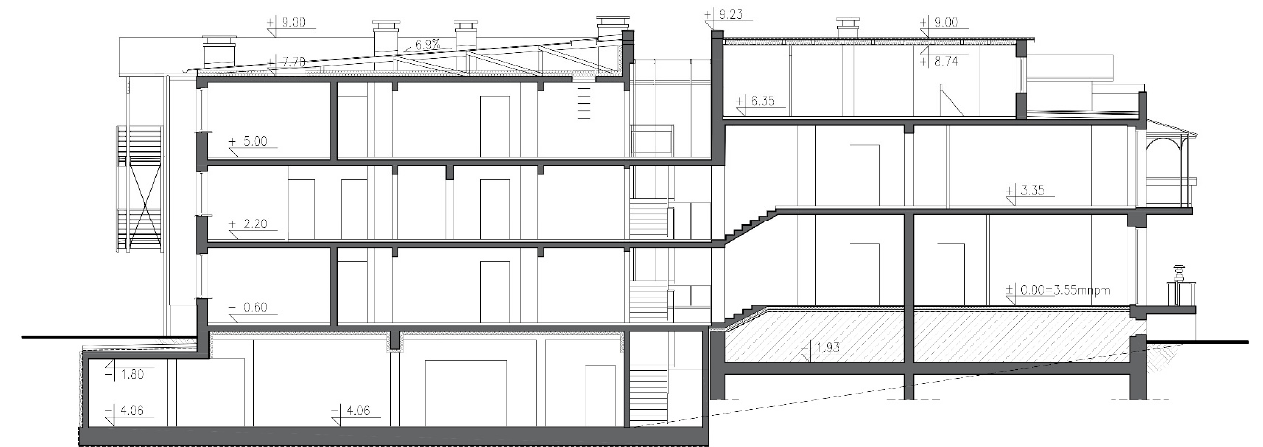
Figure 12. Willa Halina, longitudinal section through the building. Source: FORT Taraszkiewicz Architekci.